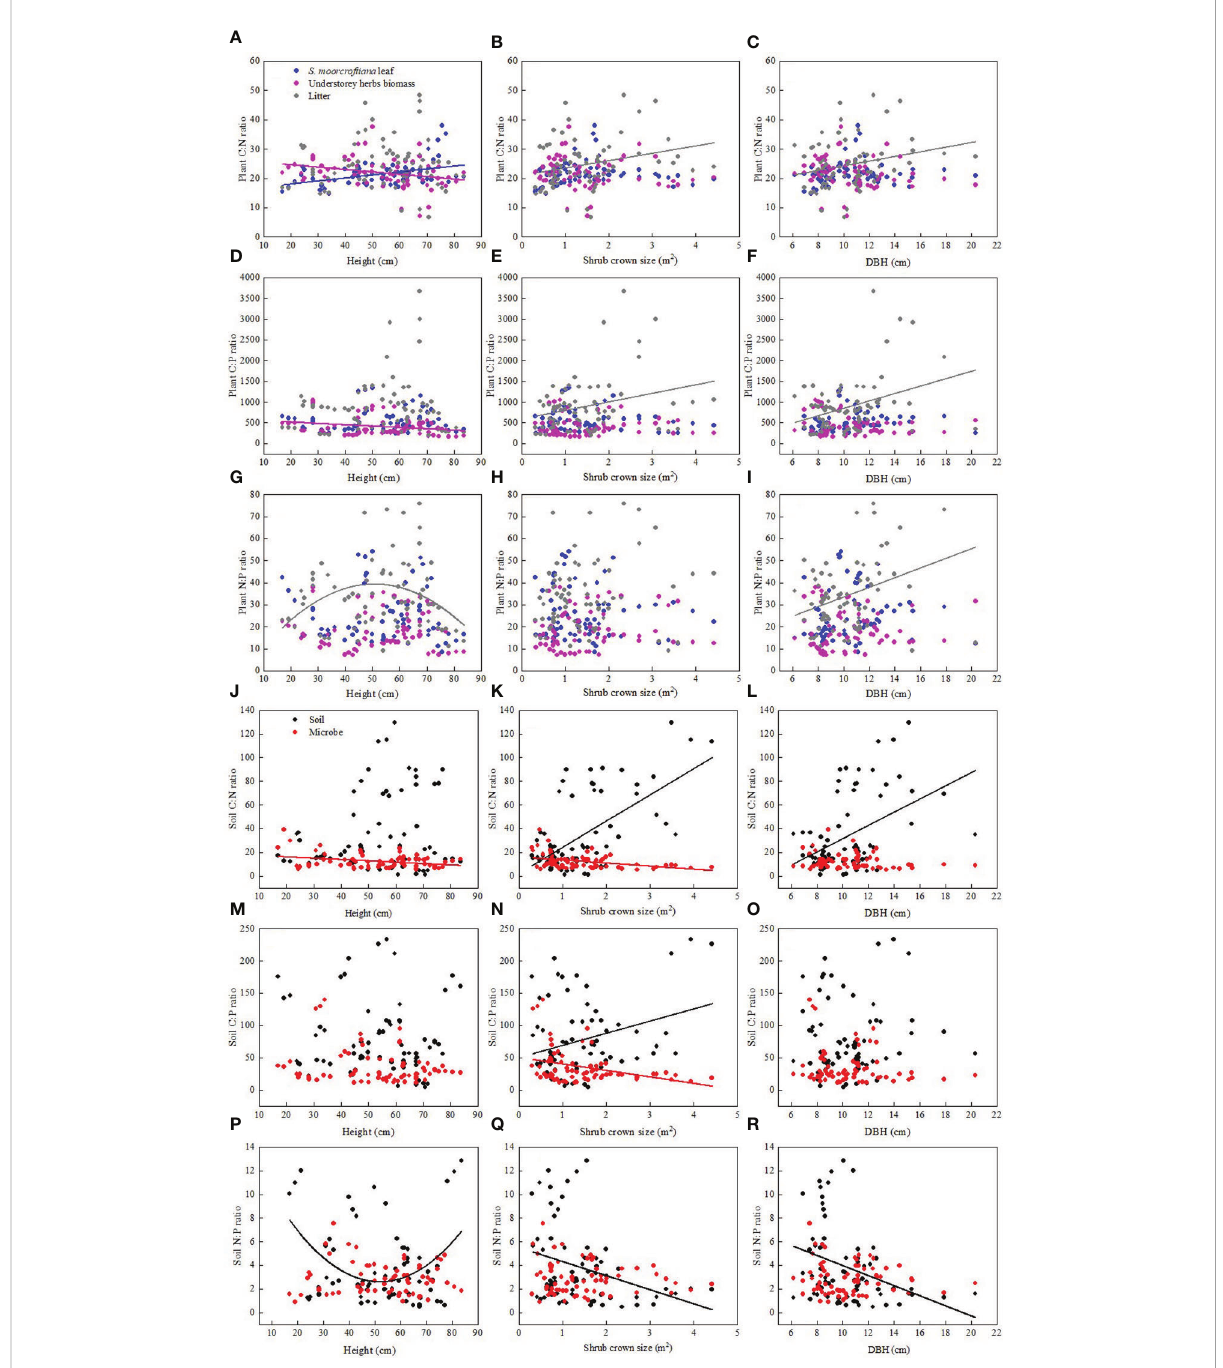
FIGURE 5 Relationships between Sophora moorcroftiana height and plant stoichiometry (A – G) , shrub crown size and plant stoichiometry (B – H) diameter at breast height (DBH) and plant stoichiometry (C – I) , Sophora moorcroftiana height and soil stoichiometry (J – P) , shrub crown size and soil stoichiometry (K – Q) , diameter at breast height (DBH) and soil stoichiometry (L – R) ,